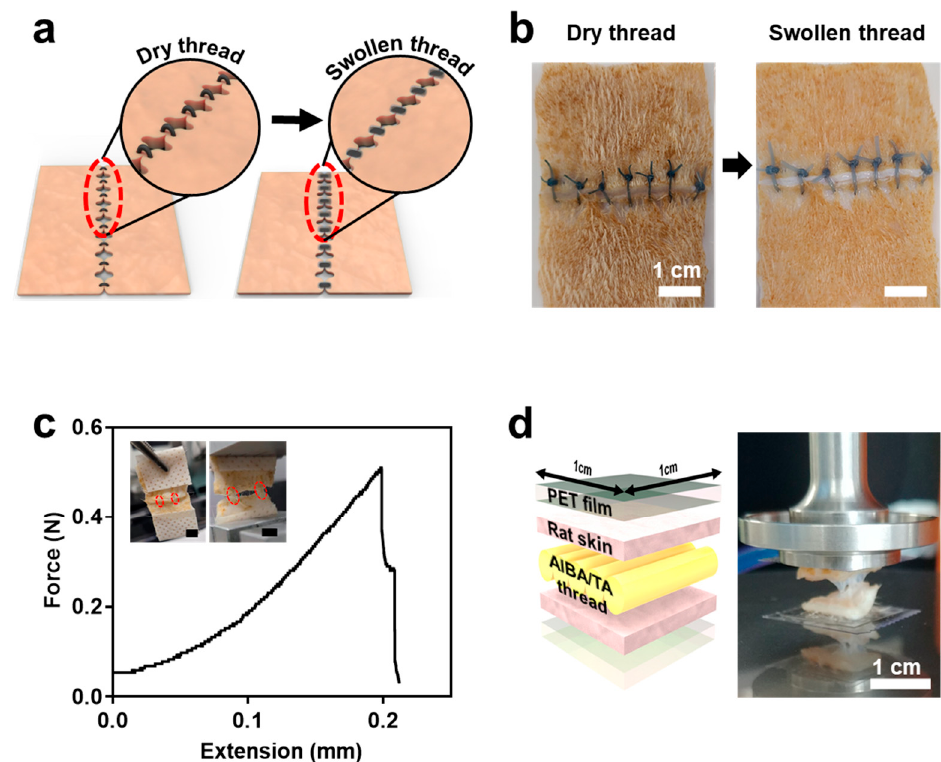
Figure 4. ( a ) Schematic description for ex vivo suturing test using the AlBA/TA hydrogel threads. Dried ( left ) and swollen suturing after exposure to PBS (pH 7.4) ( right ). ( b ) The seven-stitched suturing of rat dorsal skins by the adhesive threads. ( c ) Force (N)–extension (mm) curve of the sutured skins with two stitches using two-layered AlBA/TA threads (scale bar = 0.5 cm). ( d ) Schematic illustration for evaluating tissue-adhesiveness of the AlBA/TA threads ( left ) and photograph showing the adhesiveness of the swollen threads to subcutaneous tissues ( right ).